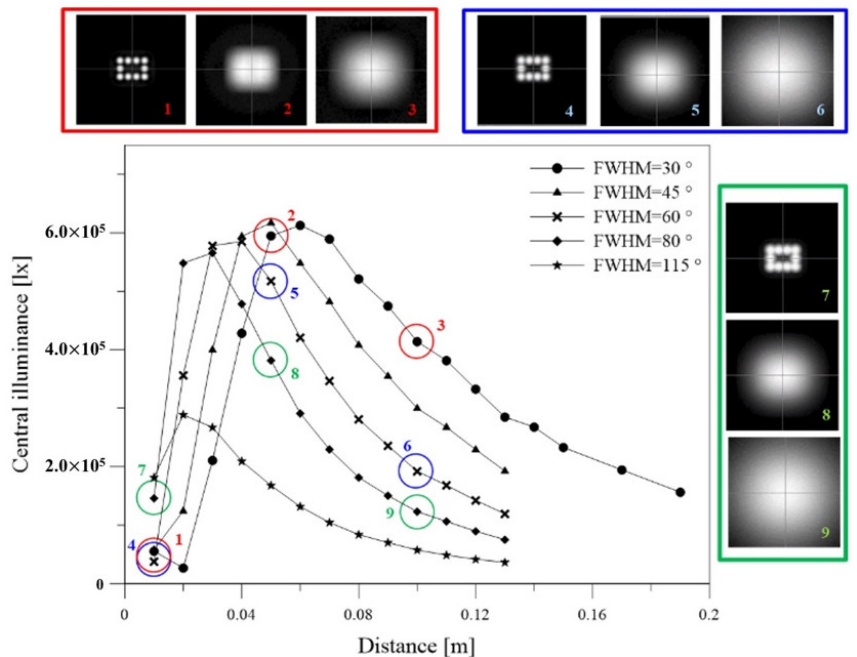
Figure 8. Central illumination location patterns in hollow array. Red, FWHM: 30 ° ; blue, FWHM: 60 ° ; green, FWHM: 80 ° .